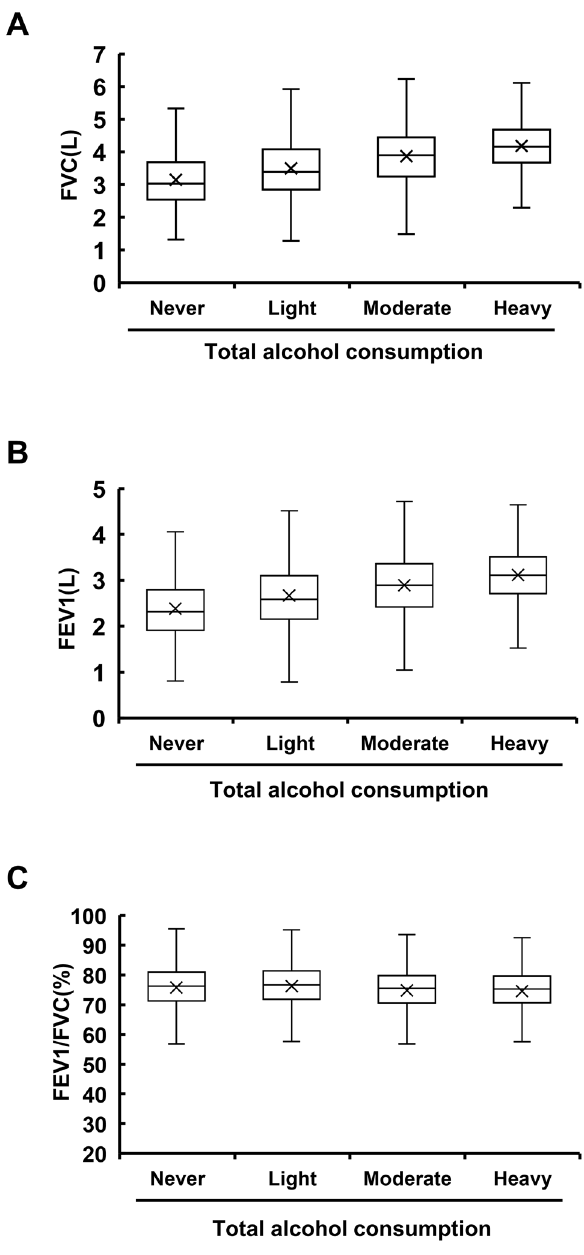
Hospital and categorized into 4 subgroups by total alcohol consumption as stated in Supplementary Table S6B. (B) Box and whisker plot of FEV1 for each category of alcohol consumption. (C) Box and whisker plot of the FEV1/FVC ratio for each category of alcohol